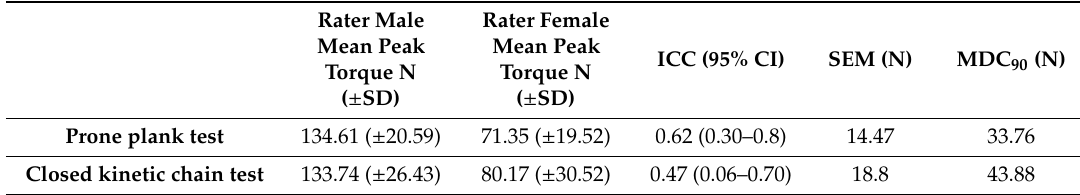
Table 4. Intertester intrasession reliability results (T1) for both test (N = 22). N = Newton; SD = standard deviation; ICC = intraclass correlation coe ffi cient; SEM = standard error of measurement; MDC 90 = minimal detectable change 90% confidence